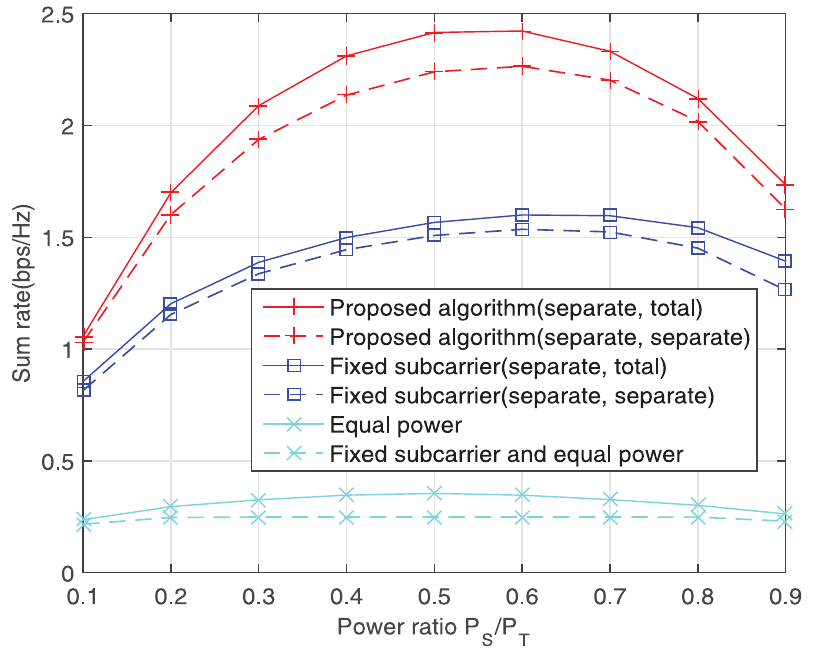
Fig 5. Effect of power ratio on the sum rate, where Q 1 = Q 2 = 0dB and average SNR = 10dB.